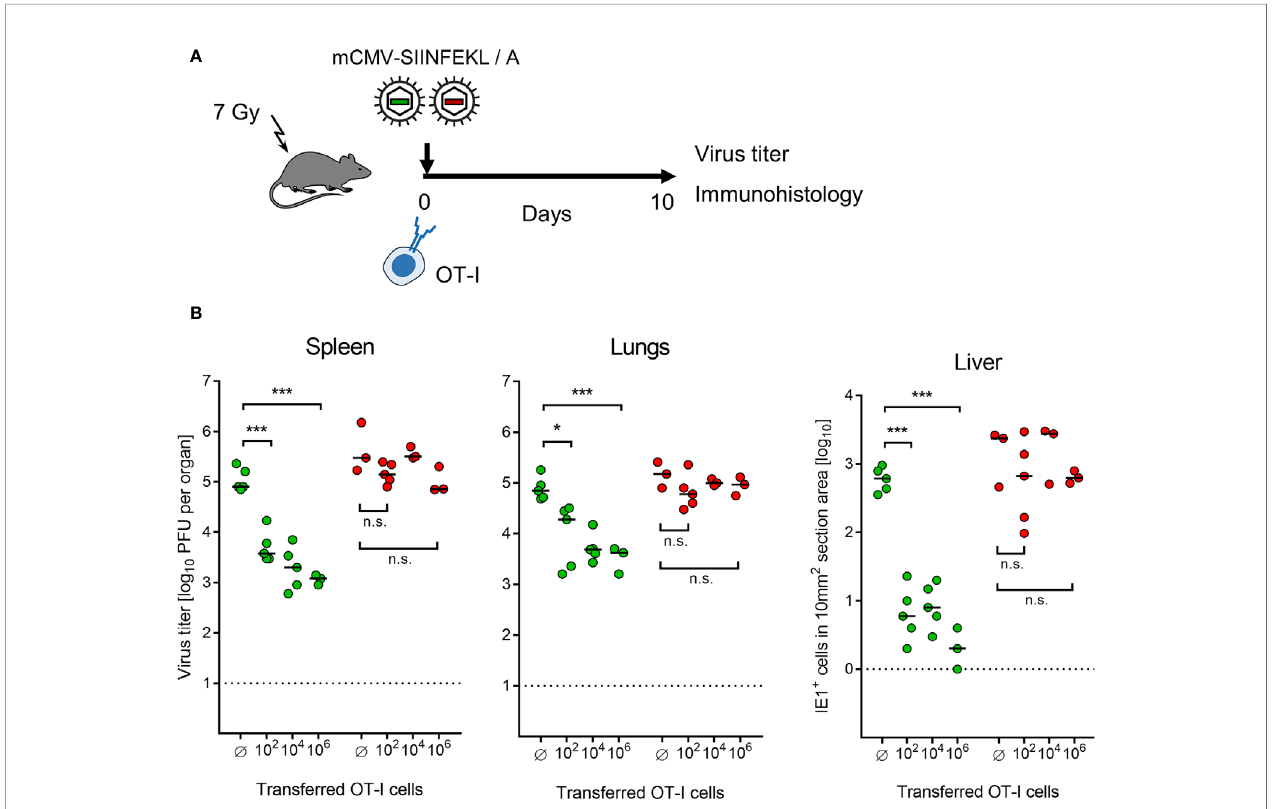
FIGURE 3 | Control of organ infection by ACT of OT-I cells. (A) Experimental protocol. OT-I cells were transferred intravenously into immunocompromised C57BL/6 mice on the day of intraplantar infection with 10 5 PFU of viruses mCMV-SIINFEKL or mCMV-SIINFEKA. (B) Virus titers in spleen and lungs, as well as numbers of infected IE1 + liver tissue cells in representative 10-mm 2 section areas were determined on day 10 after infection and transfer of graded numbers of OT-I cells. (Ø) no OT-I cells transferred. Symbols (green: mCMV-SIINFEKL, red: mCMV-SIINFEKA) represent data from individually tested mice, with the median values marked. Signi fi cance levels (*) P < 0.05, (***) P < 0.001. (n.s.), not signi fi cant ( P >